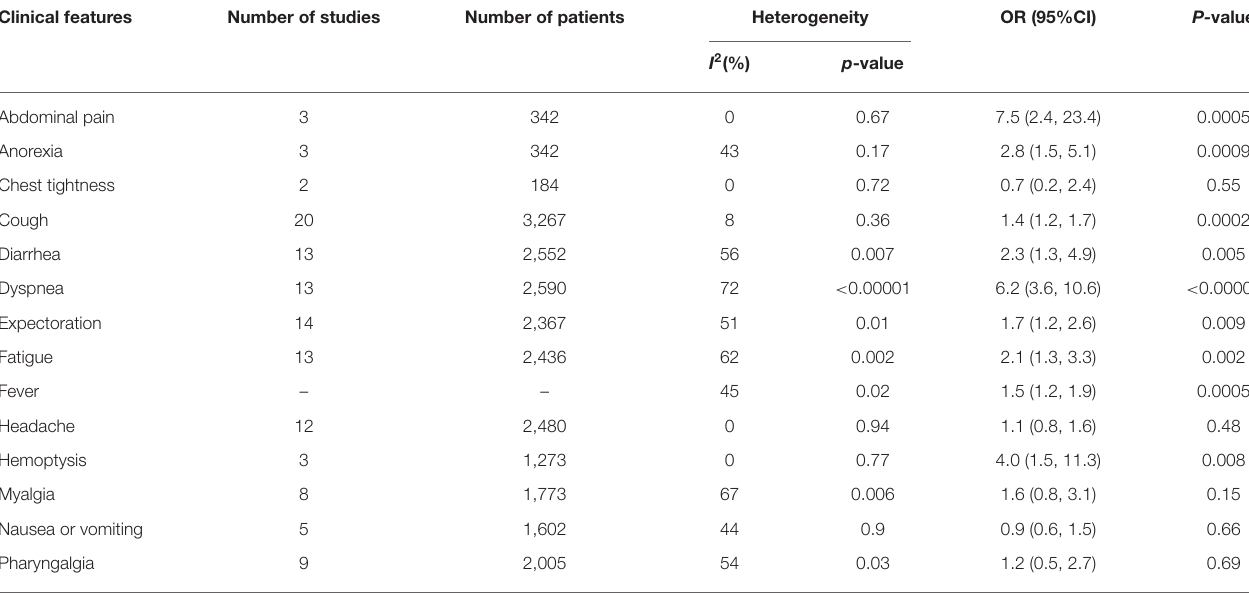
TABLE 3 | Meta-analysis outcomes of clinical